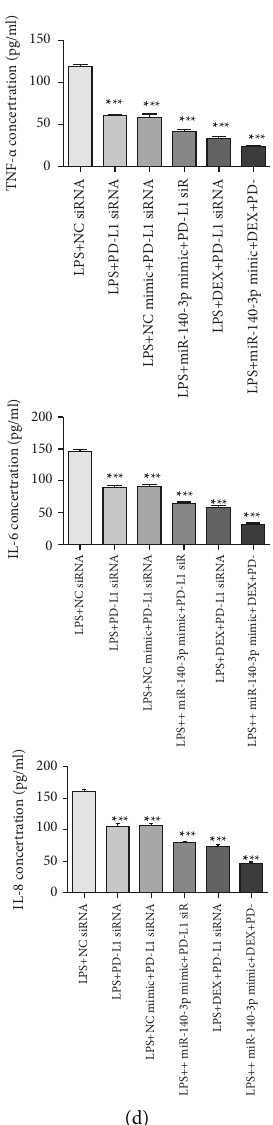
Figure 4: Effects of PD-L1 suppressing on JNK-Bnip3 pathway. (a) qPCR detected the relative expression of PD-L1 in RLE-6TN cells transfected with PD-L1 siRNAs. (b) Western blot detected the relative expression of PD-L1 in RLE-6TN cells transfected with PD-L1 siRNAs. (c) The relative expression of JNK, p-JNK, and Bnip3. (d) The levels of TNF- α , IL-6, and IL-8 in RLE-6TN cells. Data are presented as means ± SD ( n � 3; ∗ p < 0 . 05, ∗∗∗ p < 0 .